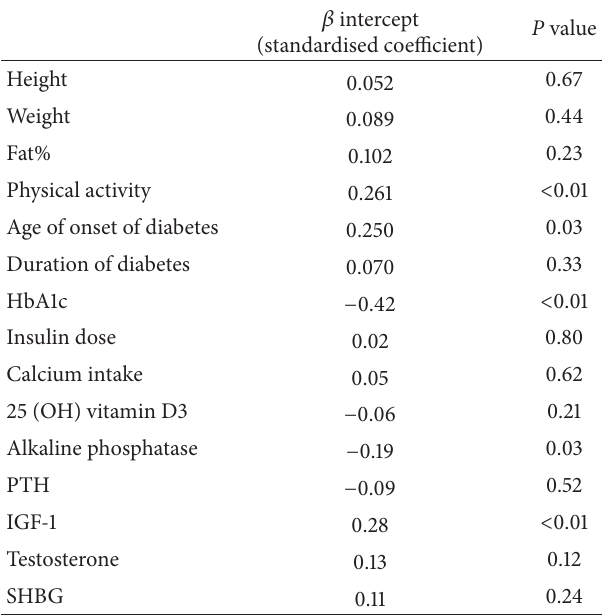
Table 7: Linear regression of parameters with bone mineral density (total body) z score (adjusted 𝑅 2 = 0.725 ; 𝑃 < 0.01 ).